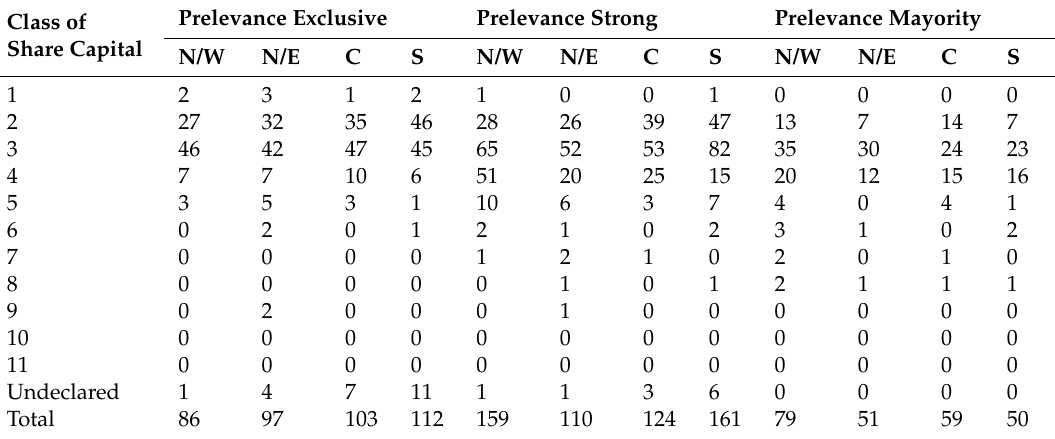
Table 5. Type of Italian woman startups (WSU) to geographical macroarea and to class of share capital. Class of Share